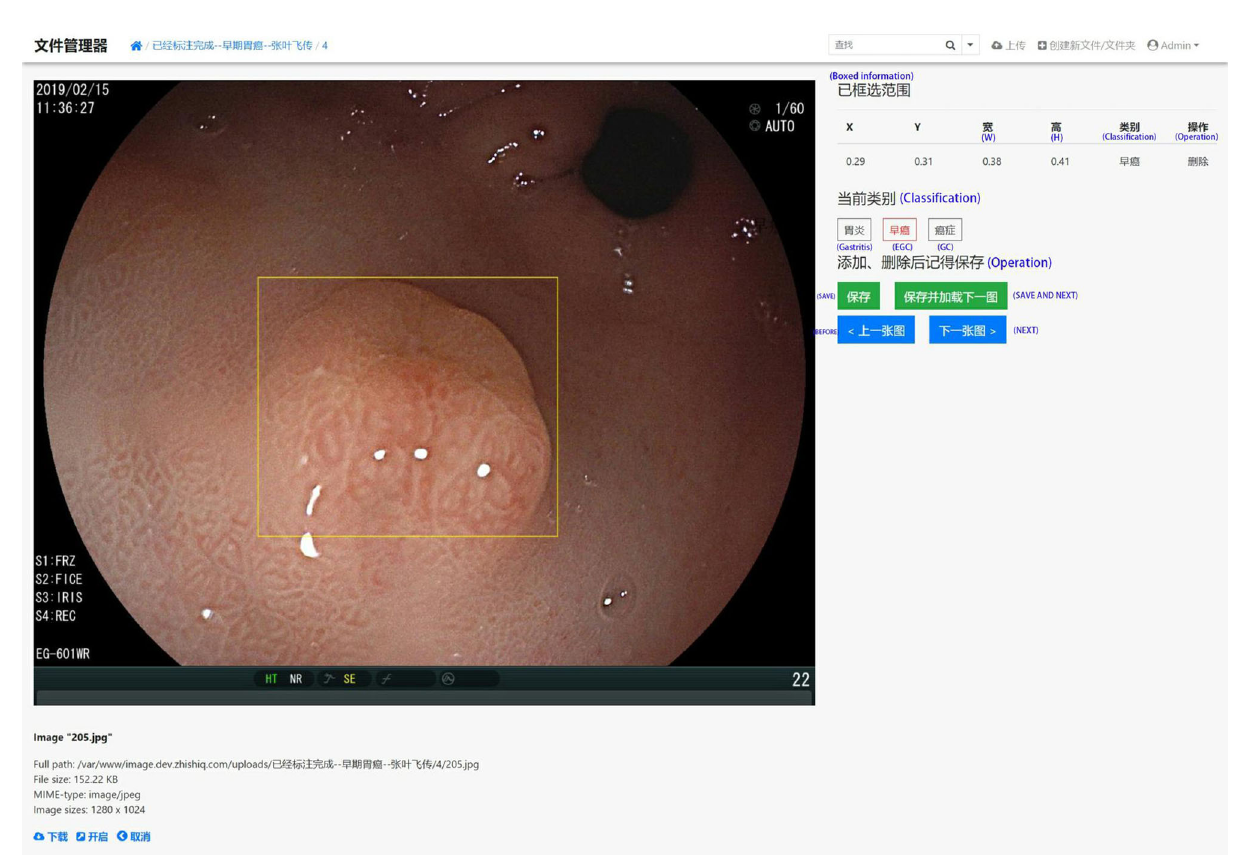
FIGURE 2 | A screenshot of the website database platform and online image annotation we created in this study. The yellow rectangular box shows the diagnosed early gastric cancer lesion. The size and location (x, y, w, and h) of the selected site were displayed in real time on the right side of the image, while the type of lesion (gastritis, early gastric cancer, progressive gastric cancer) of the selected site was annotated. The original information including source, size, format, and resolution is displayed below the